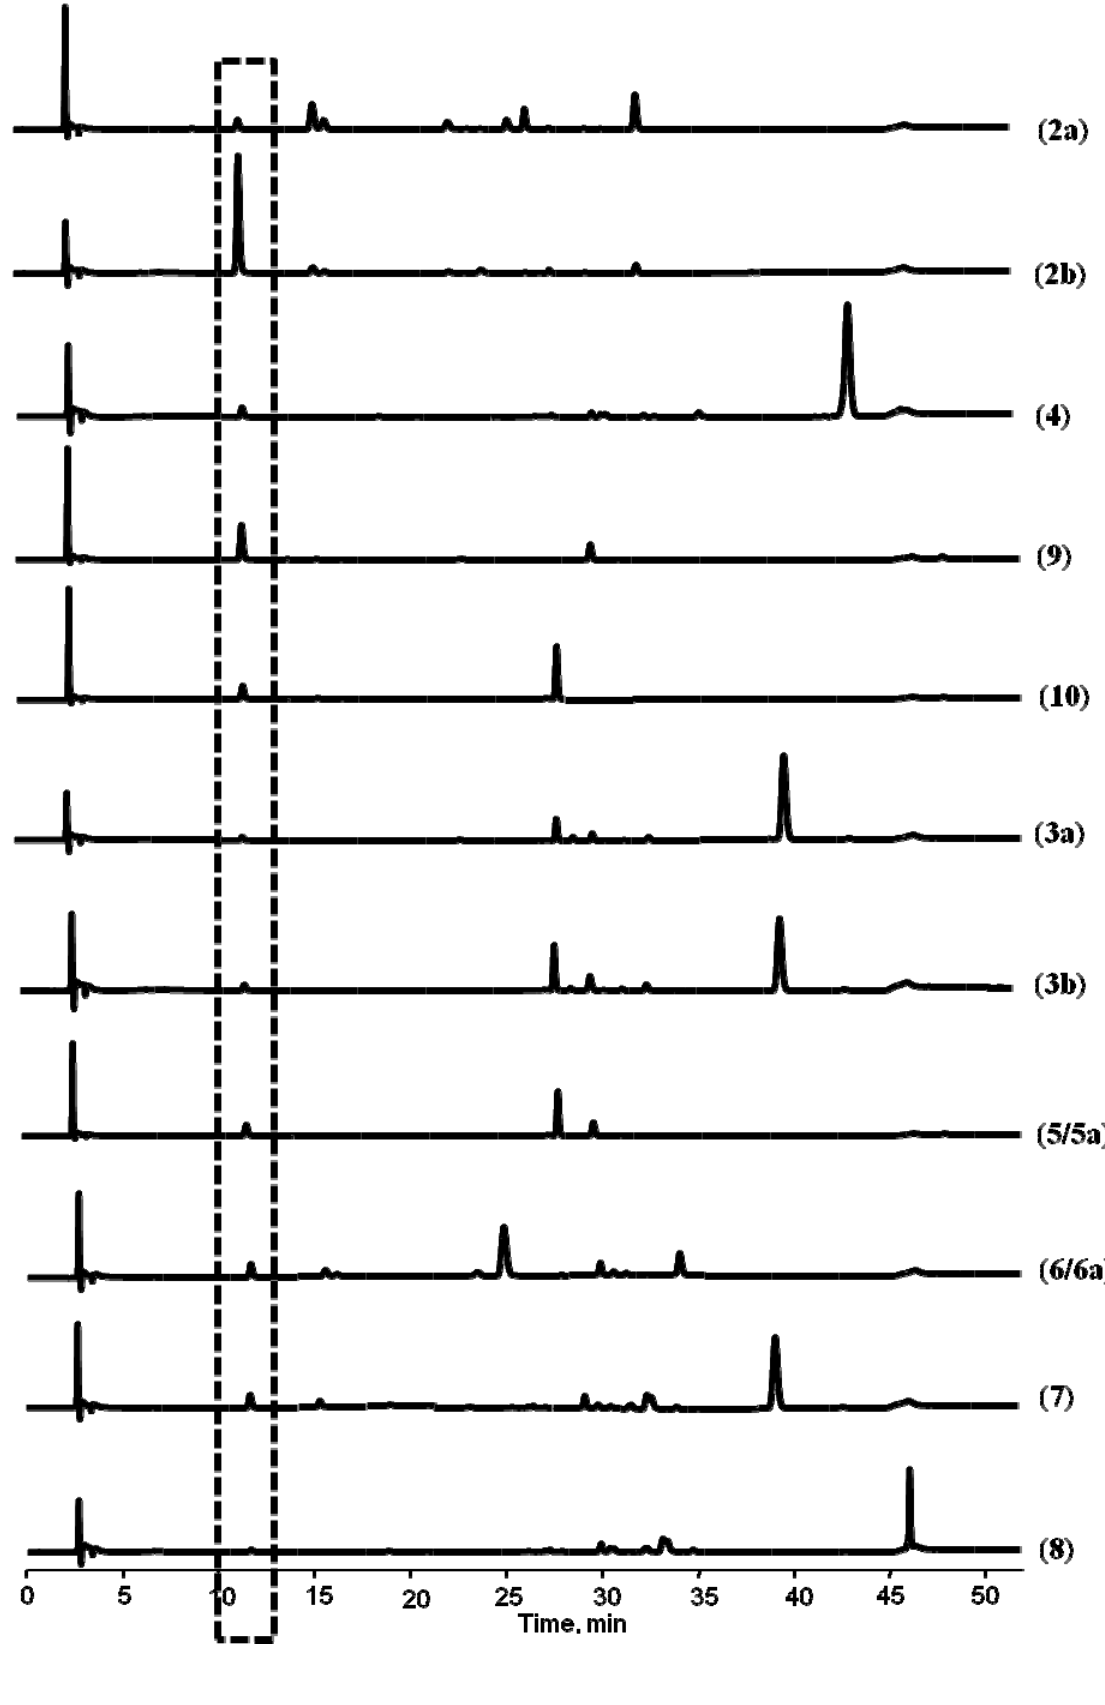
Figure 3. Typical achiral HPLC-UV (323 nm) chromatograms of incubations of compounds 2–10 in rat liver microsomes in the presence of a NADPH-regenerating